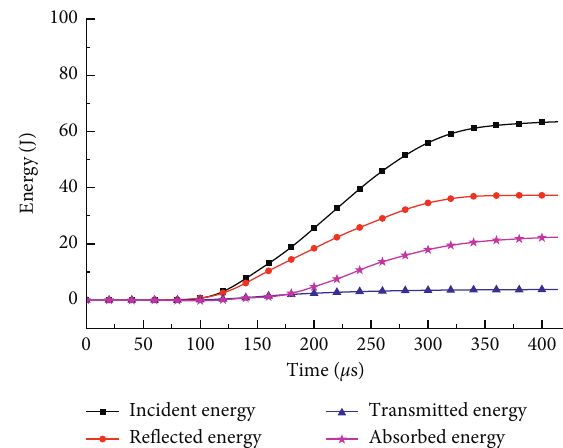
Figure 9: The energy history curve under the uniaxial state (56 s − 1 ).